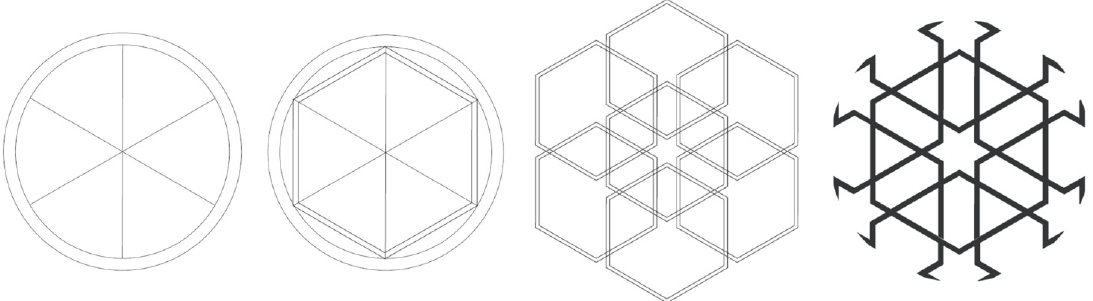
Figure 16. Prägnanz.